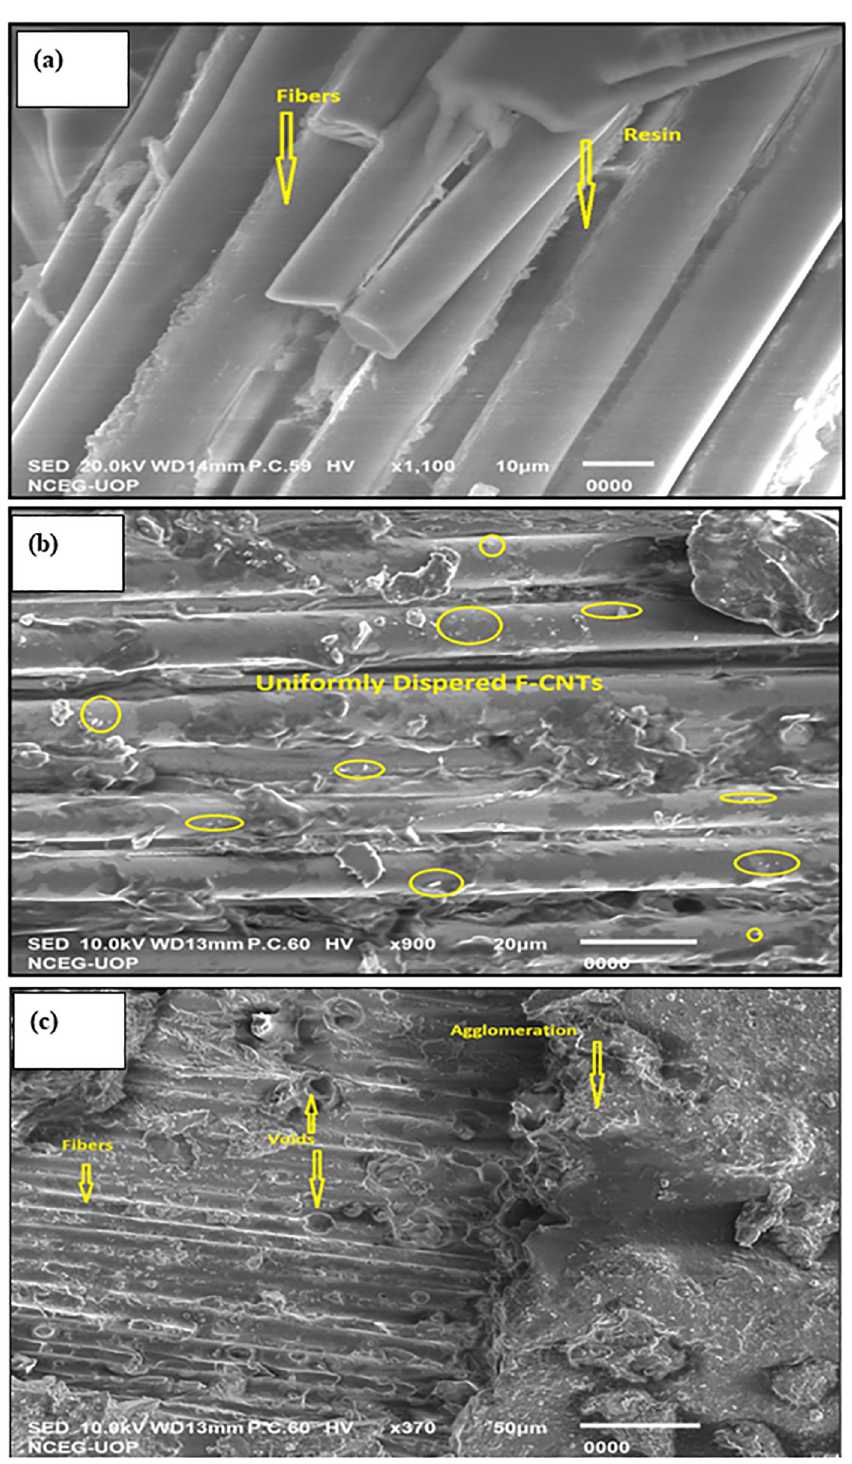
Fig 3. SEM images of the samples (a) virgin sample (b) 0.4 wt. % f-MWCNTs (c) 0.5 wt. % f—MWCNTs .